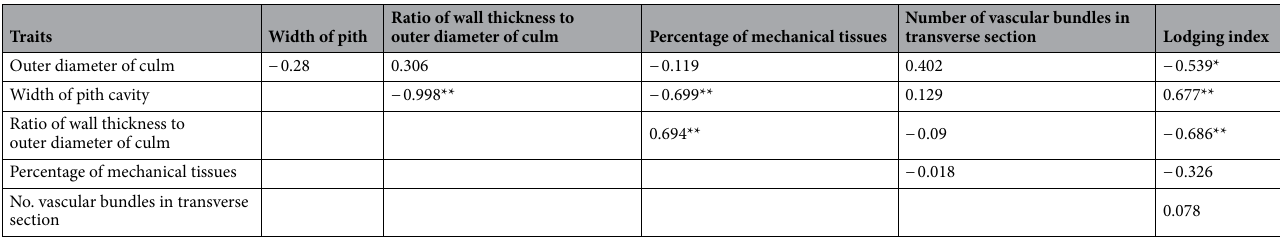
Table 6. Correlation coefficients between lodging index and traits in synthetic hexalpoid wheat in the field. *And ** indicate significant at the P < 0.05 and P < 0.01 levels, respectively.